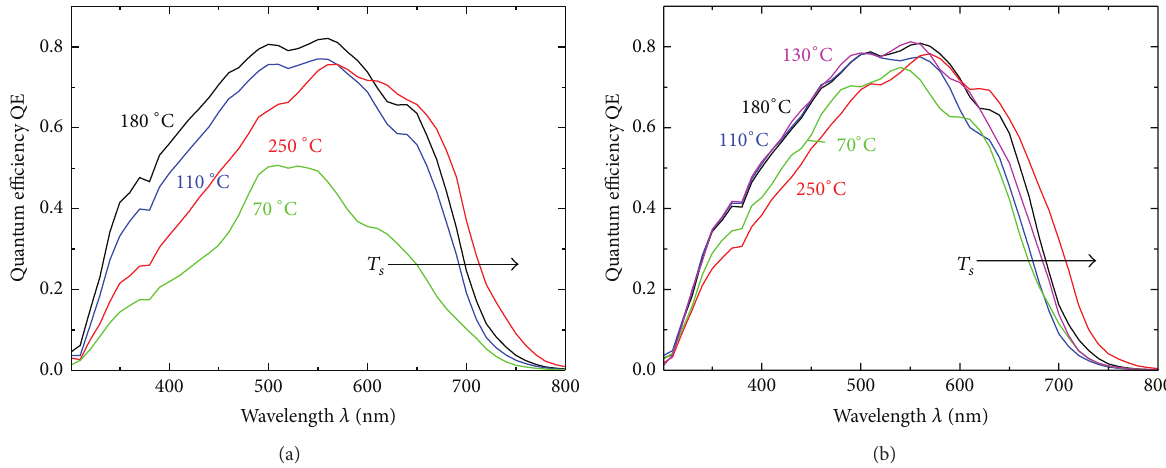
Figure 7: Quantum efficiency curves for single junction solar cells at silane concentration of (a) 10% and (b) 4% for different 𝑇 𝑠 of the absorber layer. Table 1: Photovoltaic parameters of a-Si:H/a-Si:H tandem junction solar cells fabricated with varying SC and 𝑇 𝑠 of top and bottom cell. Top